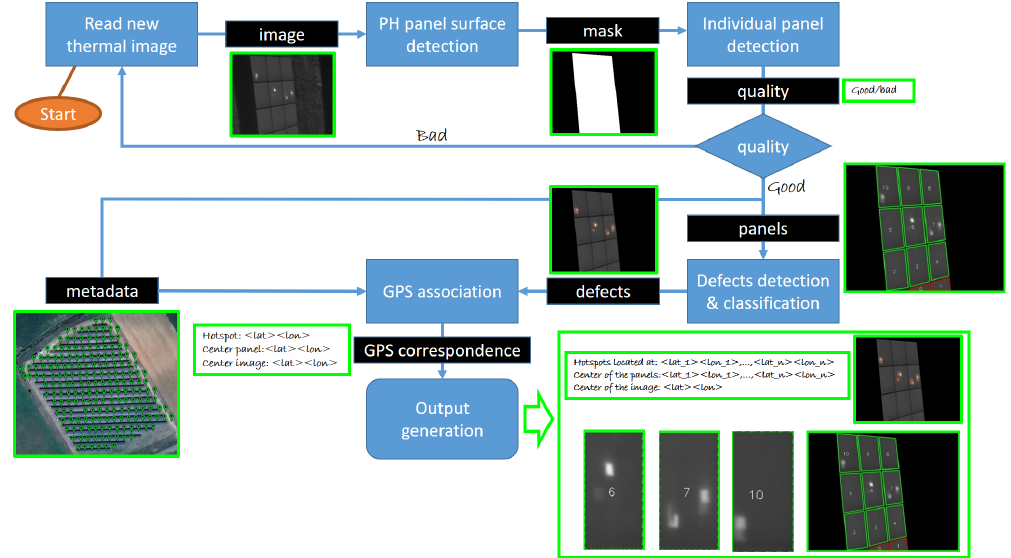
Figure 9. Main steps of the automated thermal processing